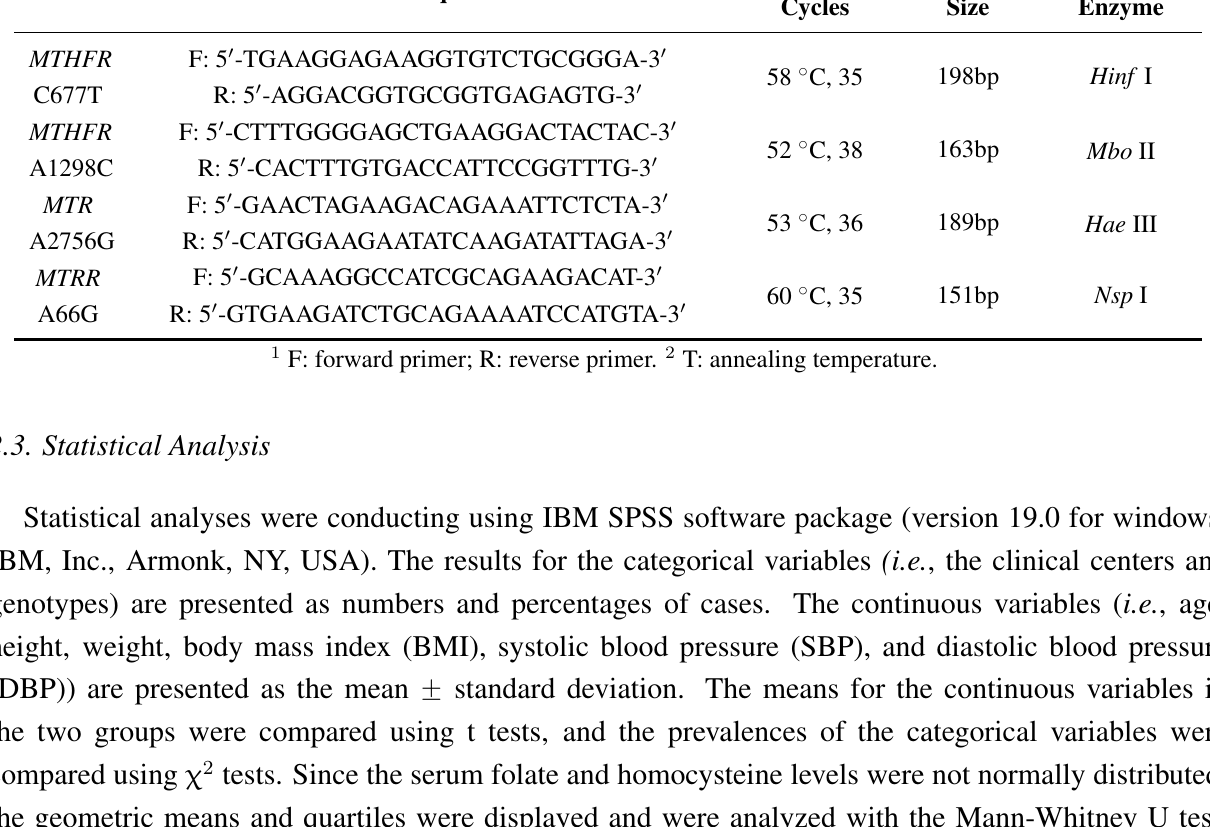
Table 1. Primer sequences and reaction conditions for PCR-RFLP of gene polymorphisms. Gene Primer sequence 1 MTHFR